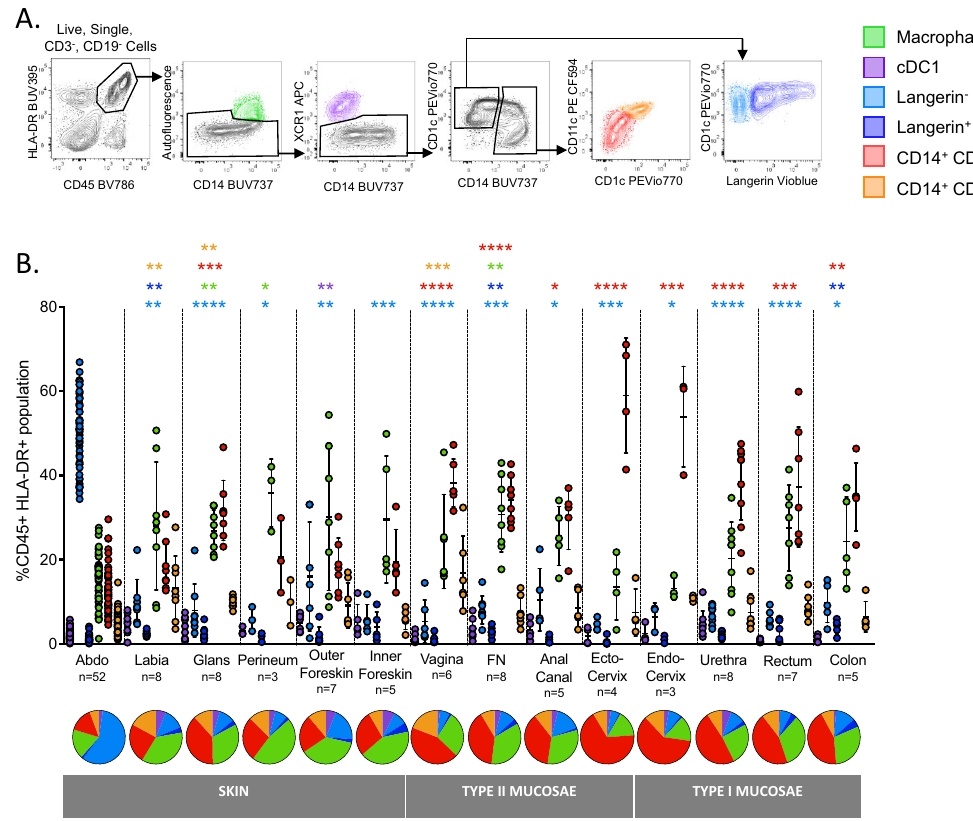
Fig. 1 De fi nition of human dermal/lamina propria mononuclear phagocytes by fl ow cytometry. A Following collagenase digestion six distinct CD3 − CD19 − CD45 + HLA-DR + mononuclear phagocyte subsets from human abdominal skin were de fi ned, (i) tissue resident macrophages (green) were de fi ned as auto fl uorescent + CD14 + , (ii) type 1 conventional dendritic cells (cDC1; purple) were de fi ned as auto fl uorescent − , XCR1 + , CD14 − , type 2 conventional dendritic cells (cDC2; blue) were de fi ned as auto fl uorescent − , XCR1 − , CD14 − , CD1c + , and could be split into two populations, (iii) a langerin − population (light blue) and (iv) a langerin + population (dark blue), (v) CD14 + CD1c − cells (red) were de fi ned as auto fl uorescent − , XCR1 − , CD14 + , CD1c − , (vi) CD14 + CD1c + cells (orange) were de fi ned as auto fl uorescent − , XCR1 − , CD14 + , CD1c + . Representative plot of n = 52 abdominal donors is shown. B Relative proportions of each subset of mononuclear phagocyte as a percentage of CD45 + HLA-DR + gate across the human anogenital/colorectal tracts were determined and mean ±standard deviation plotted. Statistics for subsets in each tissue were generated using the Kruskal – Wallis test: two-tailed Dunn ’ s multiple comparisons, comparing against abdominal skin tissue. * p <0.05; ** p <0.01; *** p < 0.001; **** p < 0.0001. (abdominal tissue (Abdo) = 52, labia = 8, glans penis = 8, perineum = 3, outer foreskin = 7, inner foreskin = 5, vagina = 6, fossa navicularis (FN) = 8, anal canal = 5, ectocervix = 4, endocervix = 3, penile urethra = 8, rectum = 7, colon = 5). Underneath, a pie chart for each tissue shows the mean proportion of each dermal/lamina propria subset across the human anogenital/colorectal